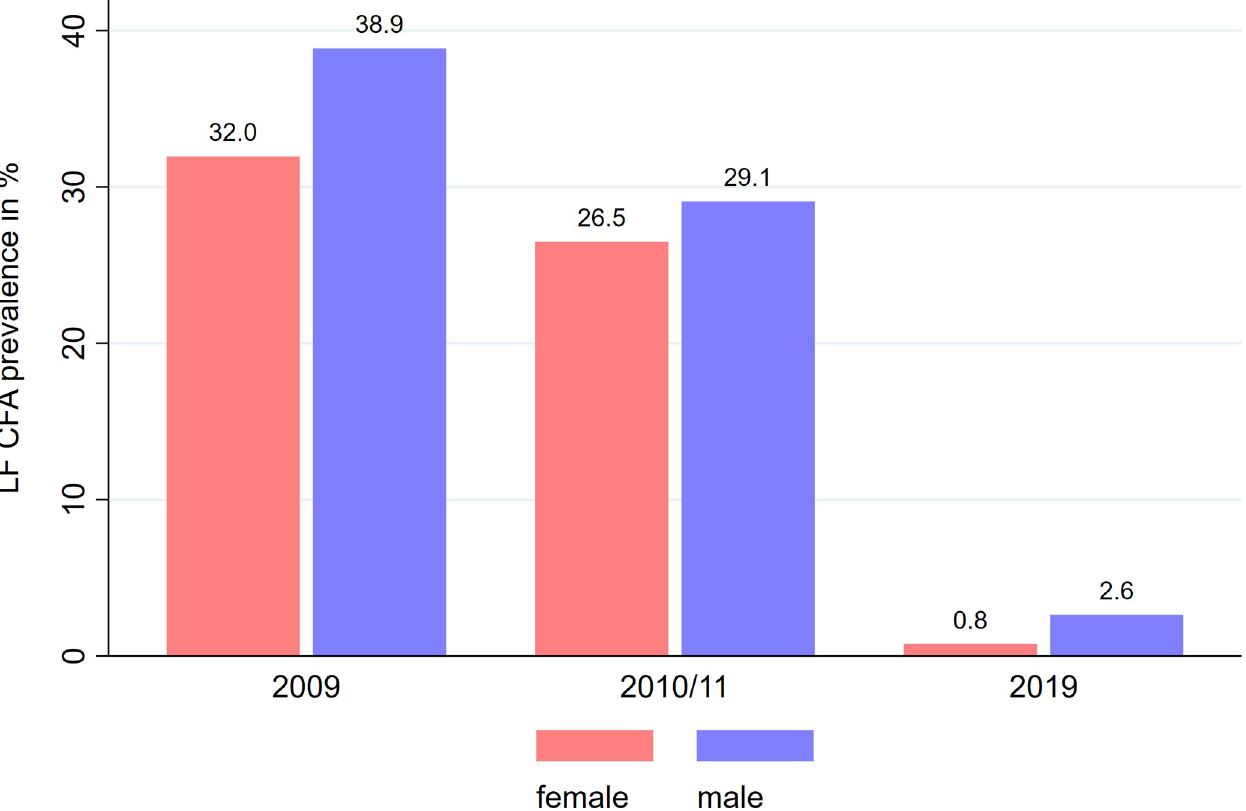
Fig 1. LF prevalence categorized by sex. The LF prevalence defined by the level of circulating filarial antigens was measured by Trop Bio ELISA in the two EMINI surveys (2009 and 2010/11) and the RHINO study (2019) in individuals 14 to 65 years in Kyela district. LF prevalence is higher in male compared with female participants in all three